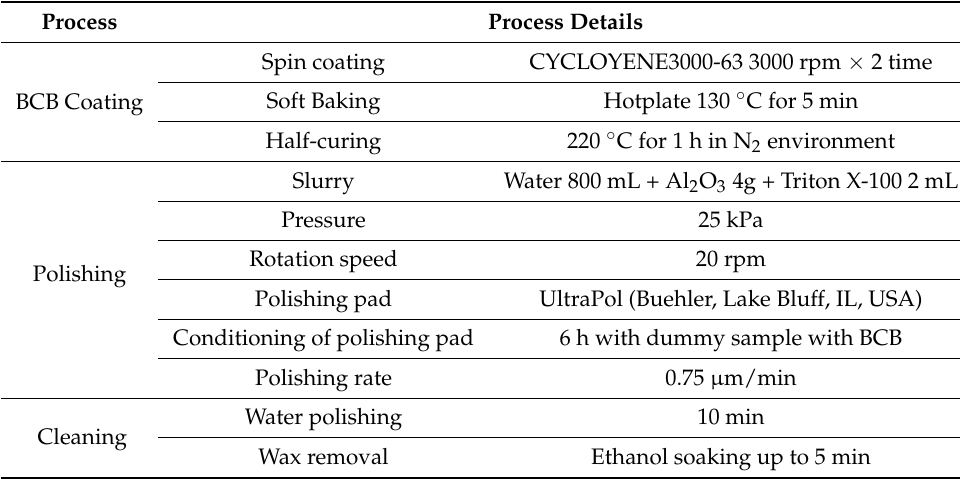
Table 1. BCB filling and polishing